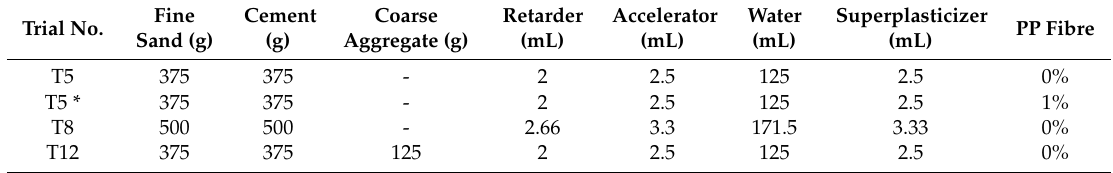
Table 2. Mortar mix design with a 1:1 ratio (cement to sand) with / without fibre. Fine Cement Coarse Trial No. Sand (g) (g) Aggregate